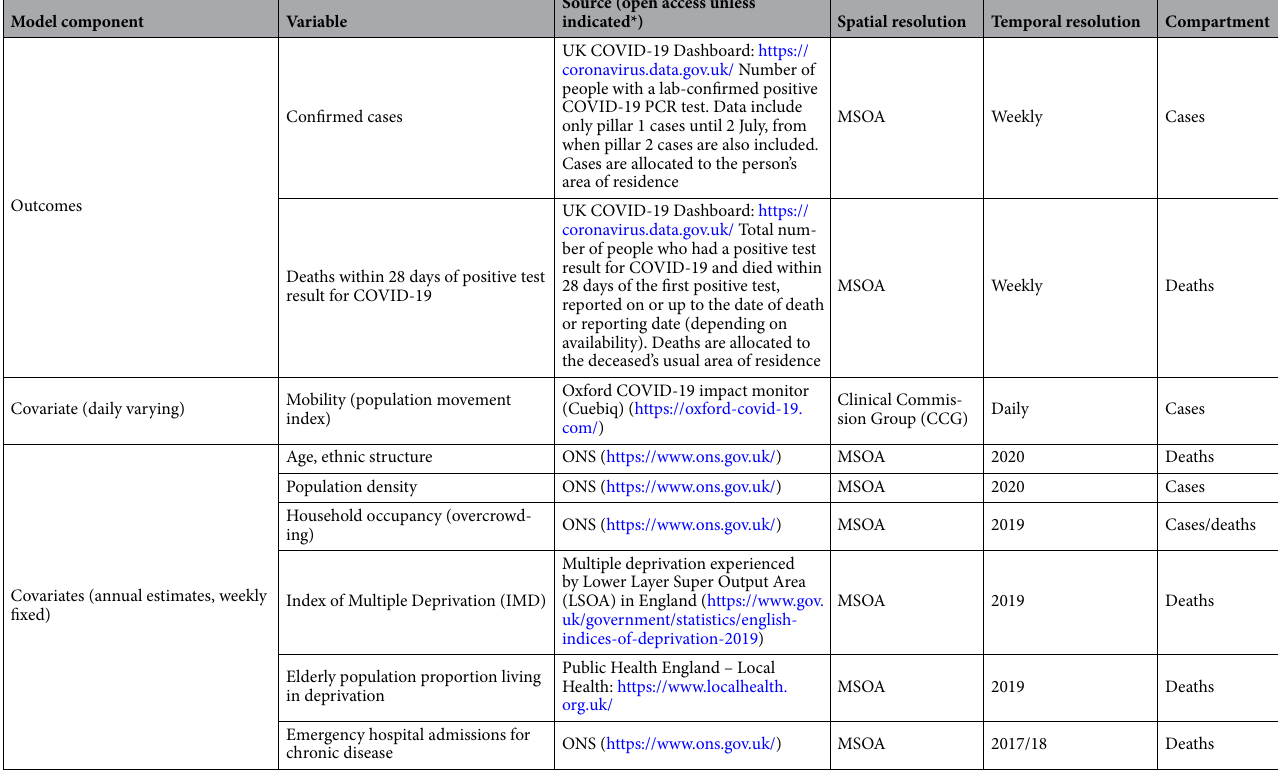
Table 2. List of model components, relevant variables and data